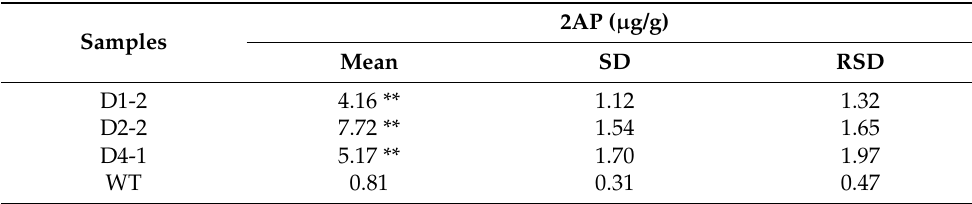
Table 2. GC-IMS quantification of 2AP contents in the seeds of T 2 mutants with CRISPR/Cas9- induced